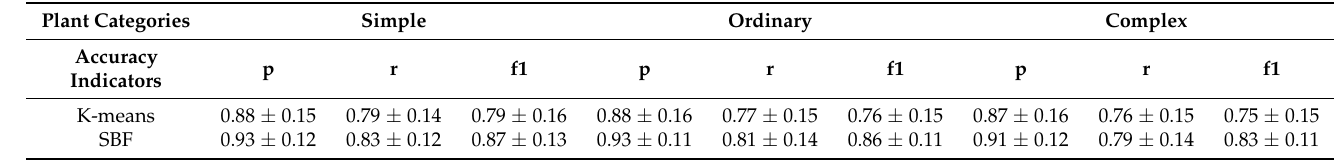
Table 3. The Mean and standard deviation of segmented overlapping leaves by SBF and K-means clustering algorithm.